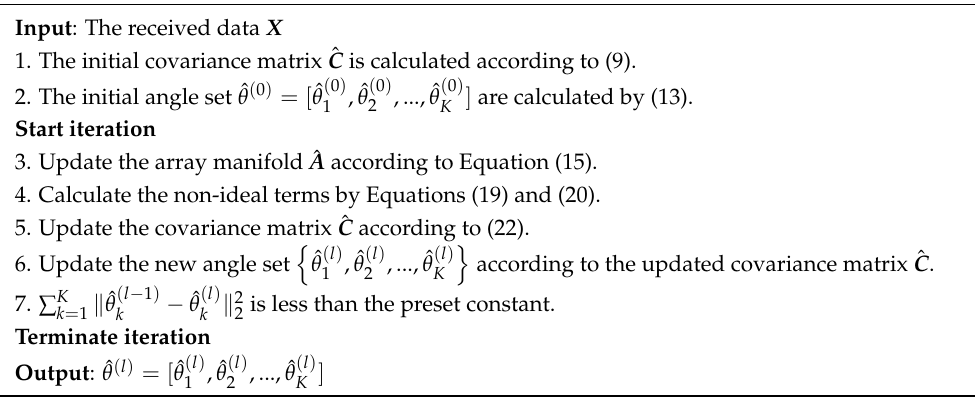
Algorithm 1 : DOA estimation via the improved URM